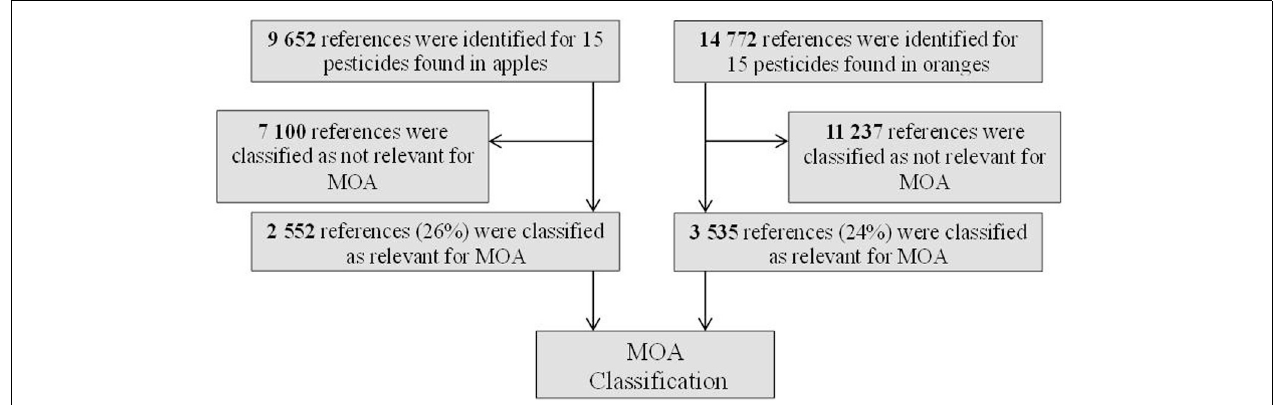
FIGURE 1 | Schematic flow chart of the tool used for classifying abstracts on the 26 selected pesticides.